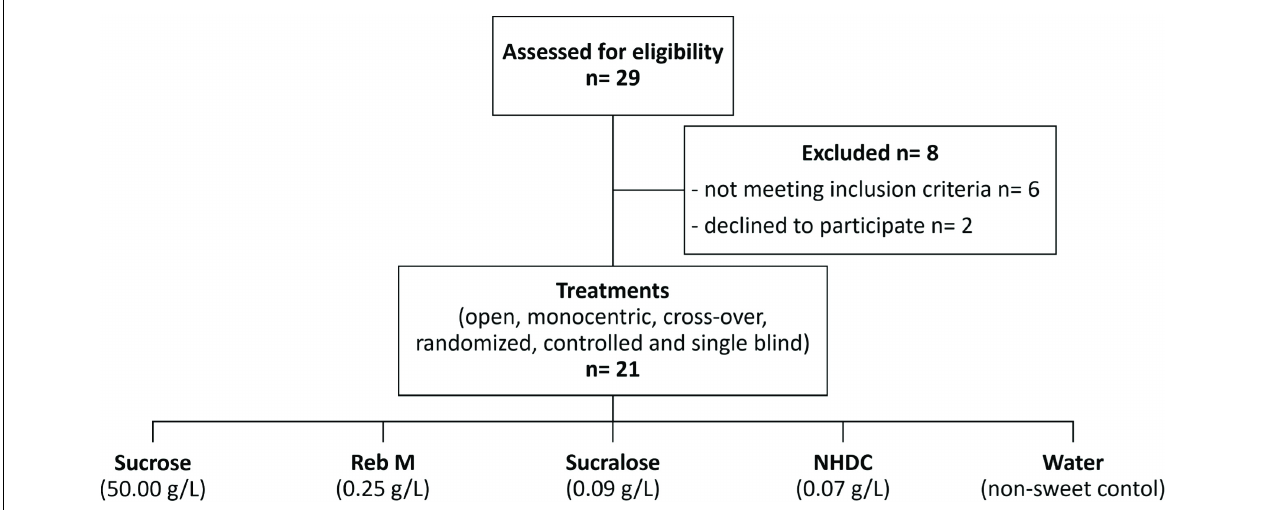
FIGURE 1 | Flow diagram of the study population and the sucrose, rebaudioside M (RebM), sucralose, and neohesperidin dihydrochalcone (NHDC) treatments at concentrations equivalent to 5% (w/v) sucrose, and water as non-sweet volume control. All of them were tested in a randomized, single blind crossover design.